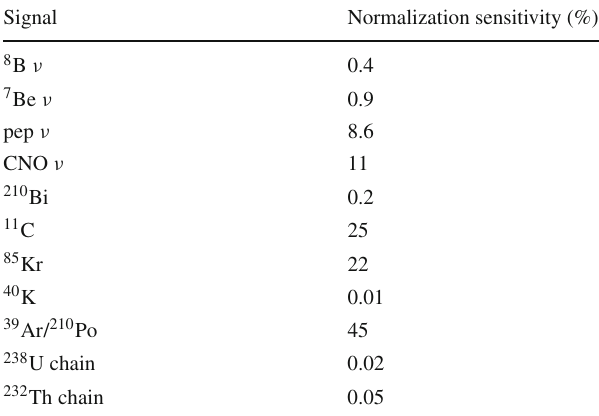
Fig. 9 Result of systematic change in energy scale modeled by a fixed percentageshiftintheenergyPDF.Thesolidlineshowsthe Δ NLLfrom fitting with a shifted PDF relative to the true PDF, with the error bars showing the RMS of the Δ NLL for many fake data sets. The dashed line shows the change in the mean extracted normalization of the CNO flux when fitting with a shifted PDF. Results are for 5 years of data with the baseline detector configuration and background assumptions